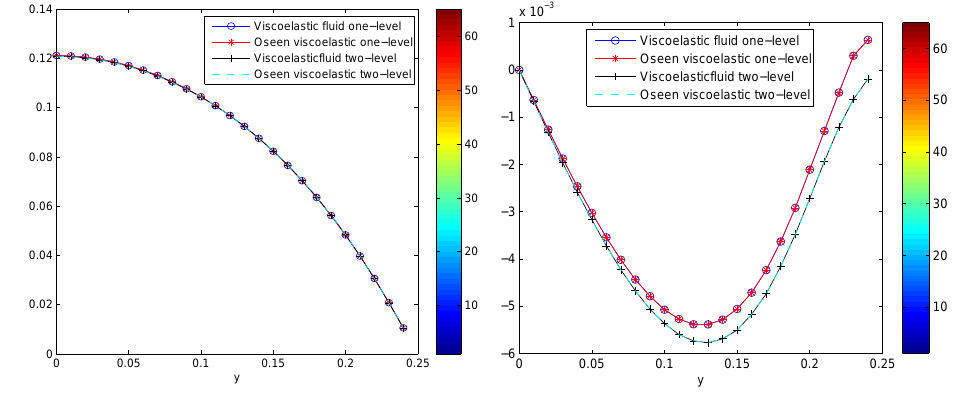
Figure 2. Horizontal velocity ( left ), vertical velocity ( right ) near re-entrant corner for steady state viscoelastic and Oseen viscoelastic fluid flow one-level and two-level